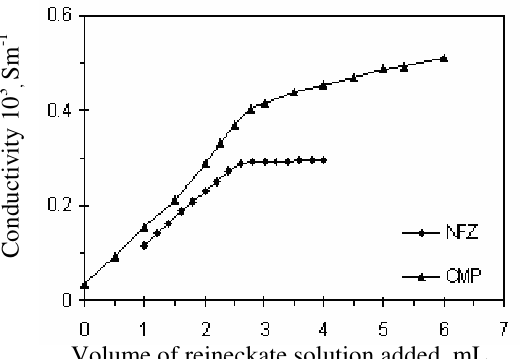
Figure 5. Conductometric titration curves of (a) 6.5 mL (2.0 × 10 -3 M) NFZ and (b) 6.9 mL (2.0 × 10 -3 M) CMP vs (5.0 × 10 −3 ) M ammonium reineckate.